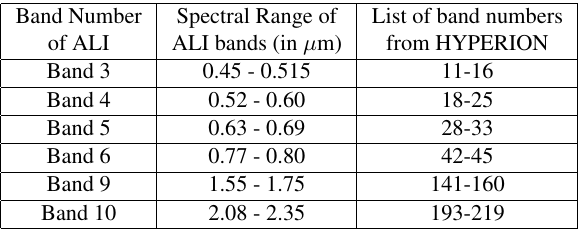
Table 1: Set of hyperspectral bands corresponding to each multi- spectral band